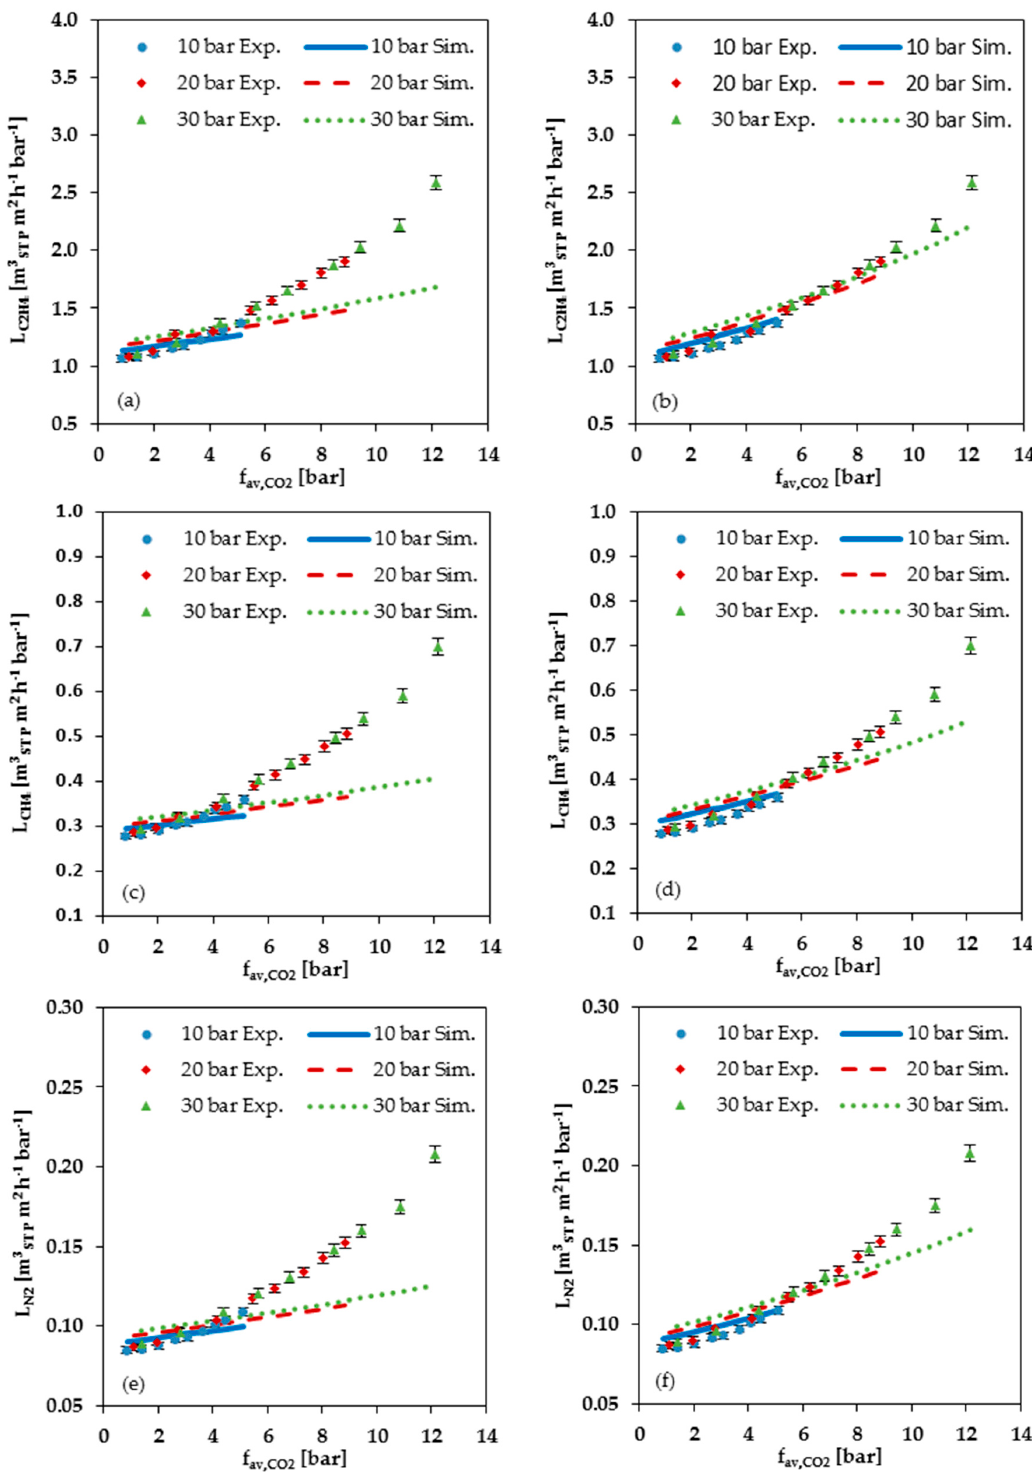
Figure 9. Comparison of measured data (Exp.) with simulated data (Sim.) for C 2 H 4 , CH 4 and N 2 permeance at 25 °C plotted against average CO 2 fugacity: ( a , c , e ) Simulation data based on FVM parameters determined from low pressure (up to 2 bar) single gas data; ( b , d , f ) Simulation data based on FVM parameters determined from high pressure (2 to 30 bar) single gas data.